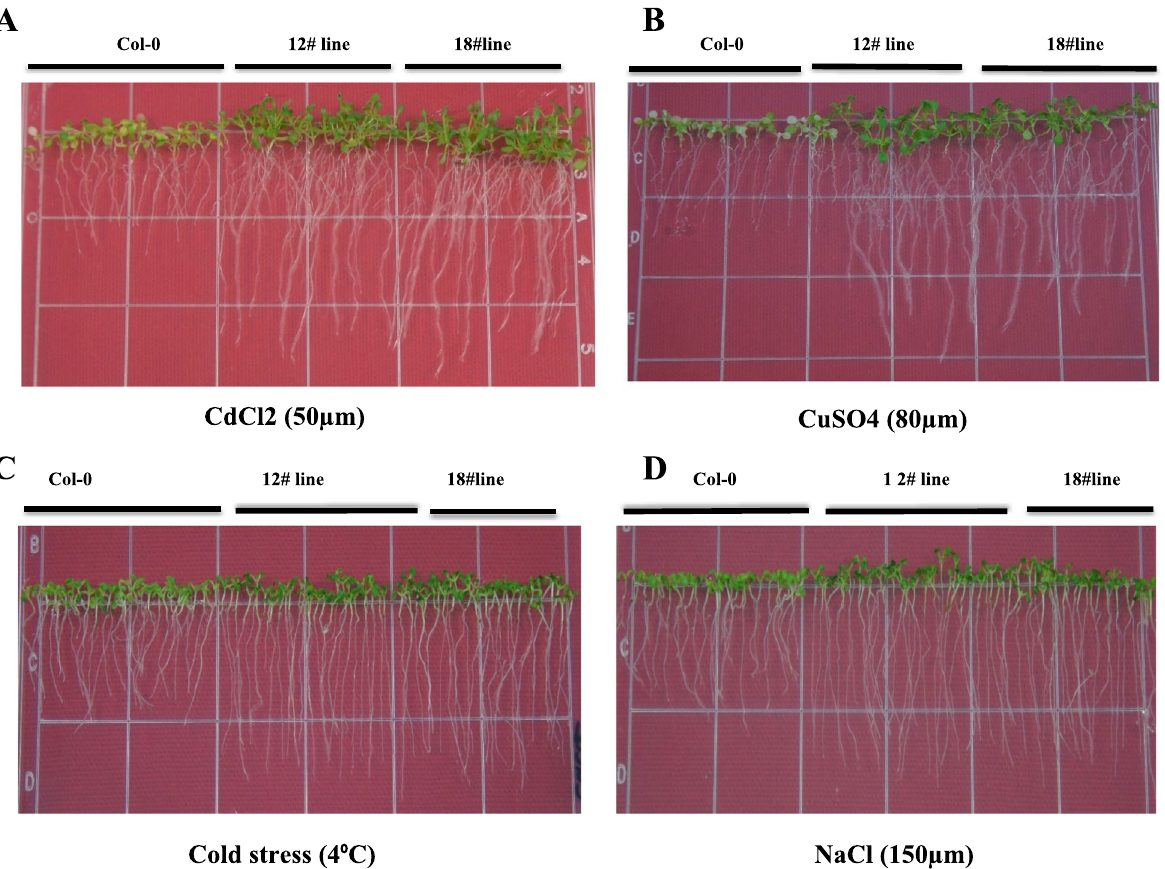
Fig. 7 Various abiotic stresses effect on AtPCR2 transgenic lines: A Heavy metal (50-μM cadmium chloride) treatment. B An 80-μM CuSO4 heavy metal treatment. C Cold stress treatment (4°C). D Salt stress (150-mM sodium chloride). Col-0, columbia-0 control; AtPCR2 line, transgenic Arabidopsis